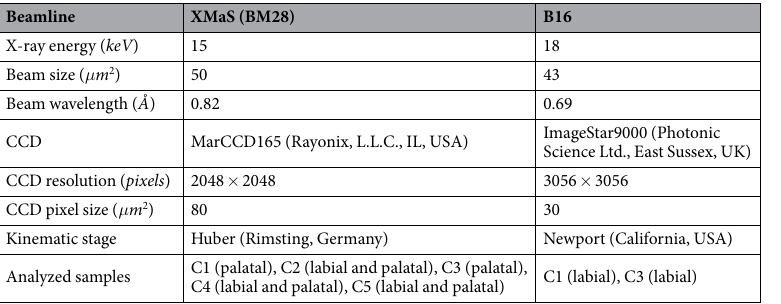
Experimental setup. To satisfy the objectives of this study, experiments were carried out using B16 and XMaS (BM28) beamlines at Diamond Light Source (DLS) and European Synchrotron Radiation Facility (ESRF), respec- tively. A schematic of the experimental setup is shown in Fig. 11a. The experimental parameters used and a list of the samples analyzed at the two synchrotron beamlines are given in Table 1.